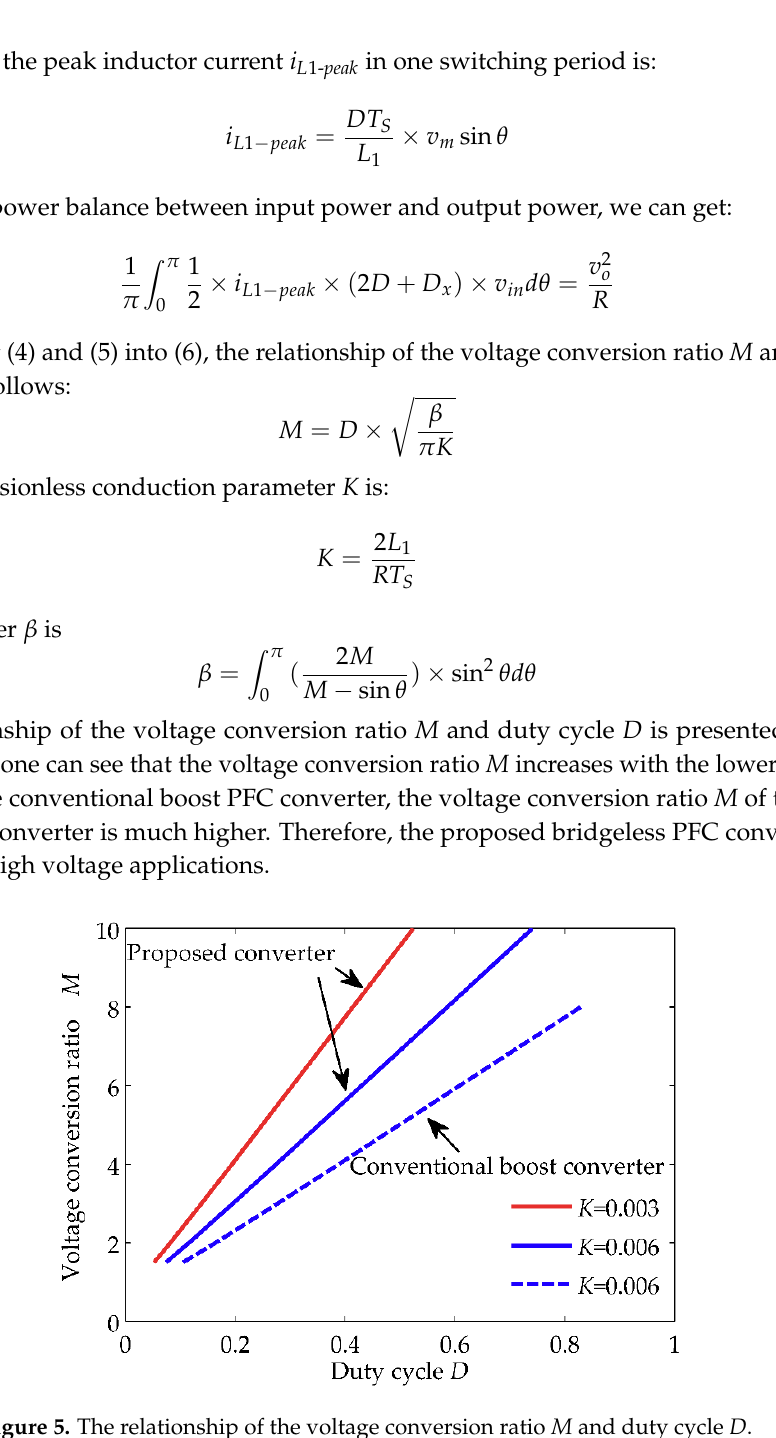
Figure 5. The relationship of the voltage conversion ratio M and duty cycle D .